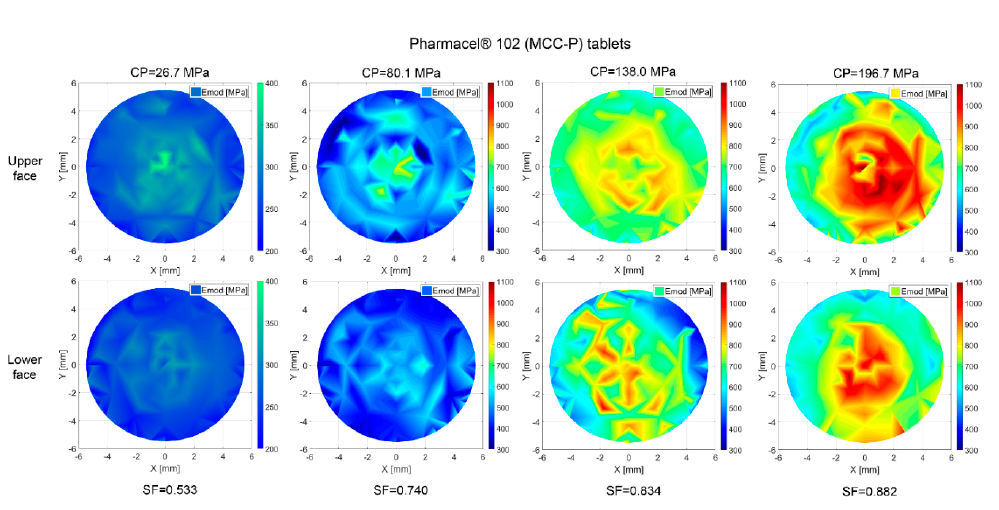
Figure 15. Fitted volumetric/weight cumulative gamma distributions ( Q 0 ) as a function of the maximum compaction pressure for the upper and lower tablet faces of the following excipients; ( a ) MCC-A; ( b ) MCC-P; ( c ) LAC; ( d ) CAPH. Sampling size: eight tablets per SF and face, 79 indents at each tablet.